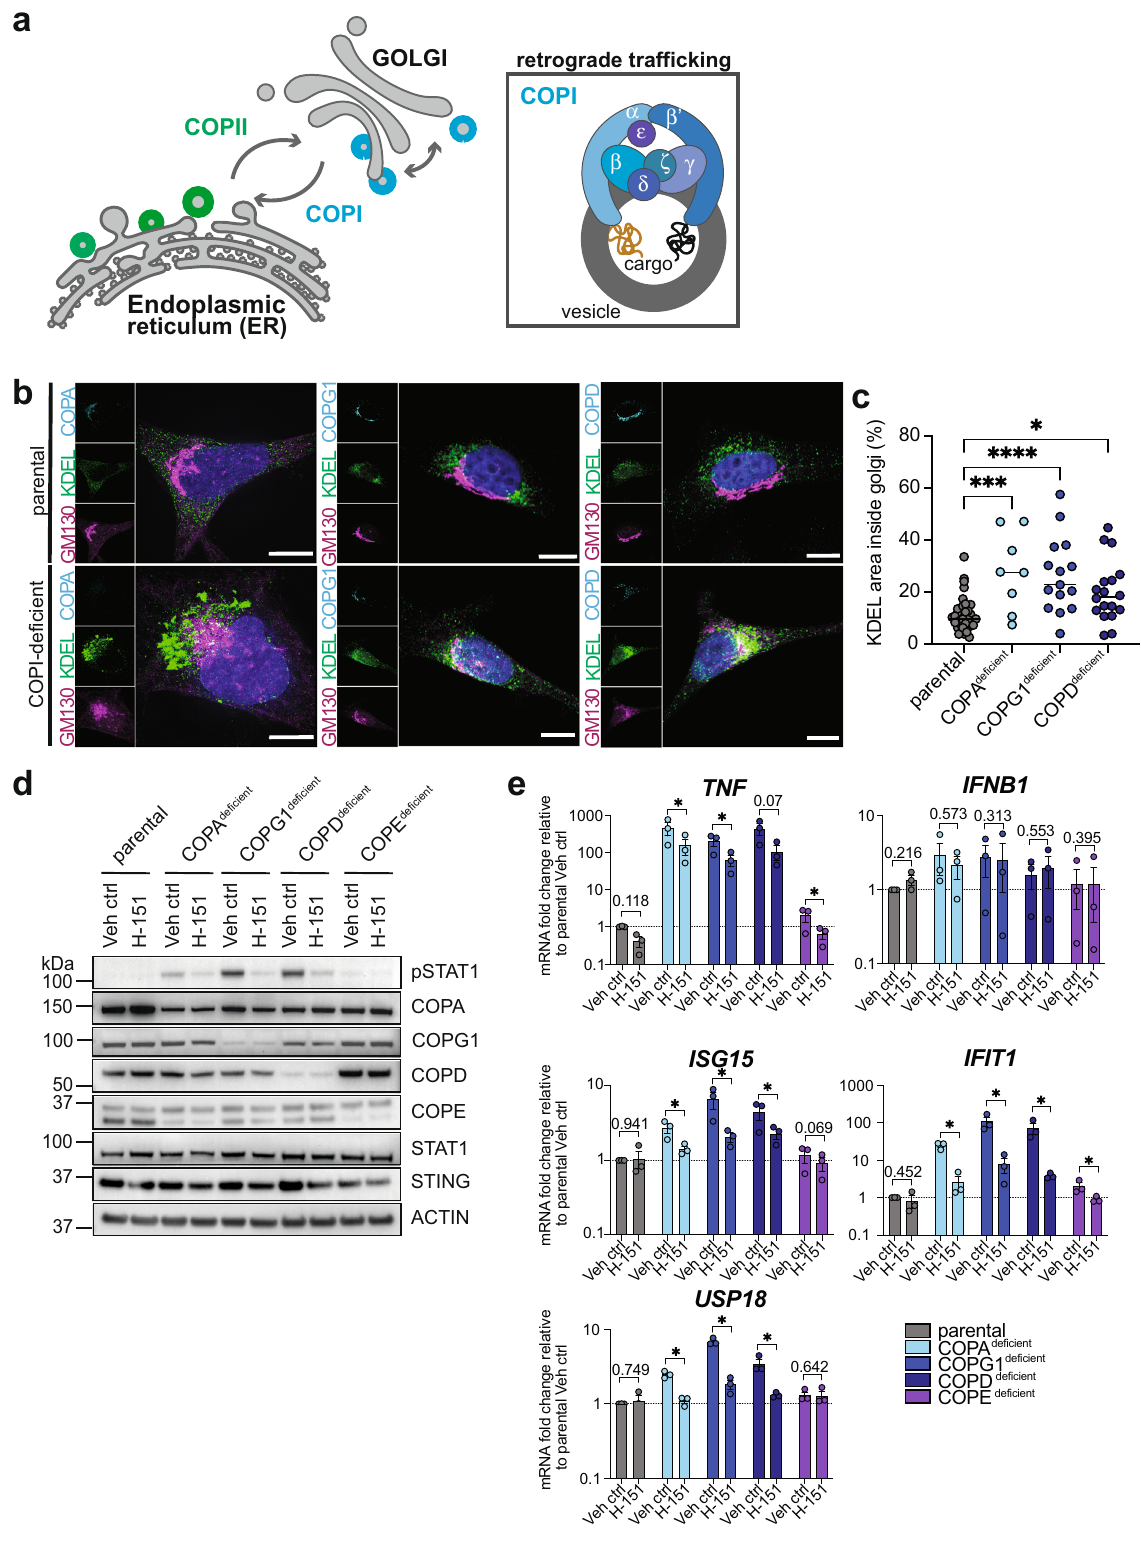
retrograde transport, whereas deletion of COPG2, implicated in intra-Golgi transport, had no effect. Despite the described differences in localization of COPG1- and COPG2-containing COPI vesicles within secretory pathway compartments 57 , the suggested functional difference between both paralogues has not yet been con fi rmed experimentally 58 .